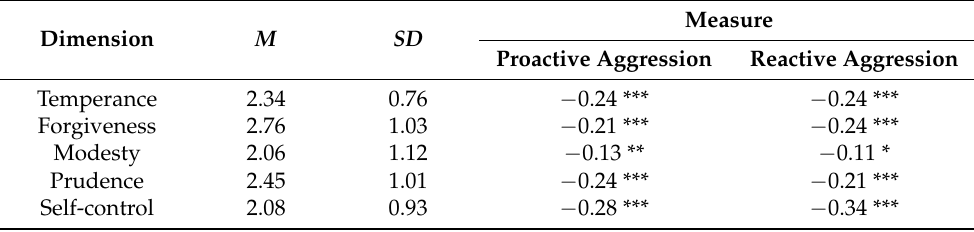
Table 6. Means, standard deviations, and correlations of dimensions of the temperance scale with measures of